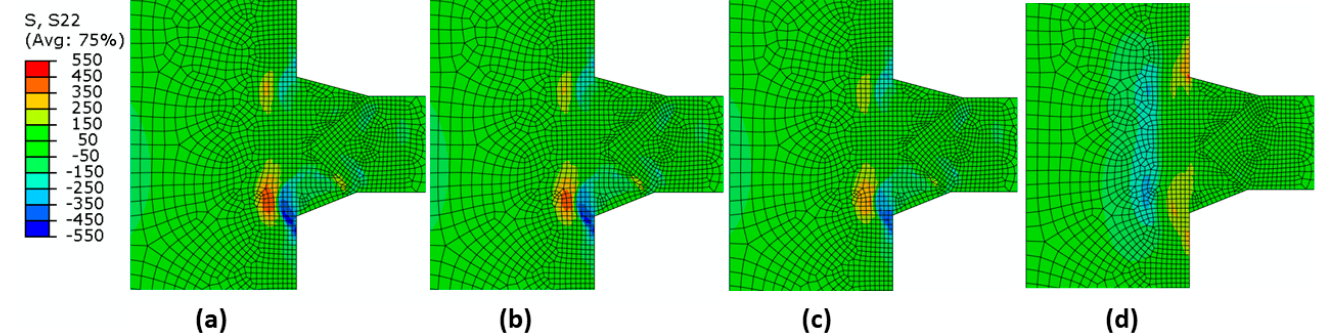
Figure 9 . Transverse residual stress in the FE model under different conditions (MPa), (a) Ms = 300 °C, (b) Ms = 350 °C, (c) Ms = 400 °C, and (d) no phase transformation.